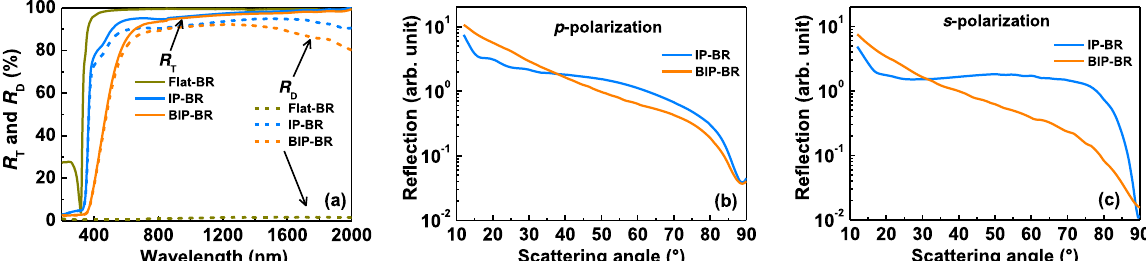
Fig. 3. Total re fl ectance ( R T , solid lines) and diffuse re fl ectance ( R D , dashed lines) of Flat-BR, IP-BR, and BIP-BR (a), and angle- resolved scattering measurements of IP-BR and BIP-BR (b and c).